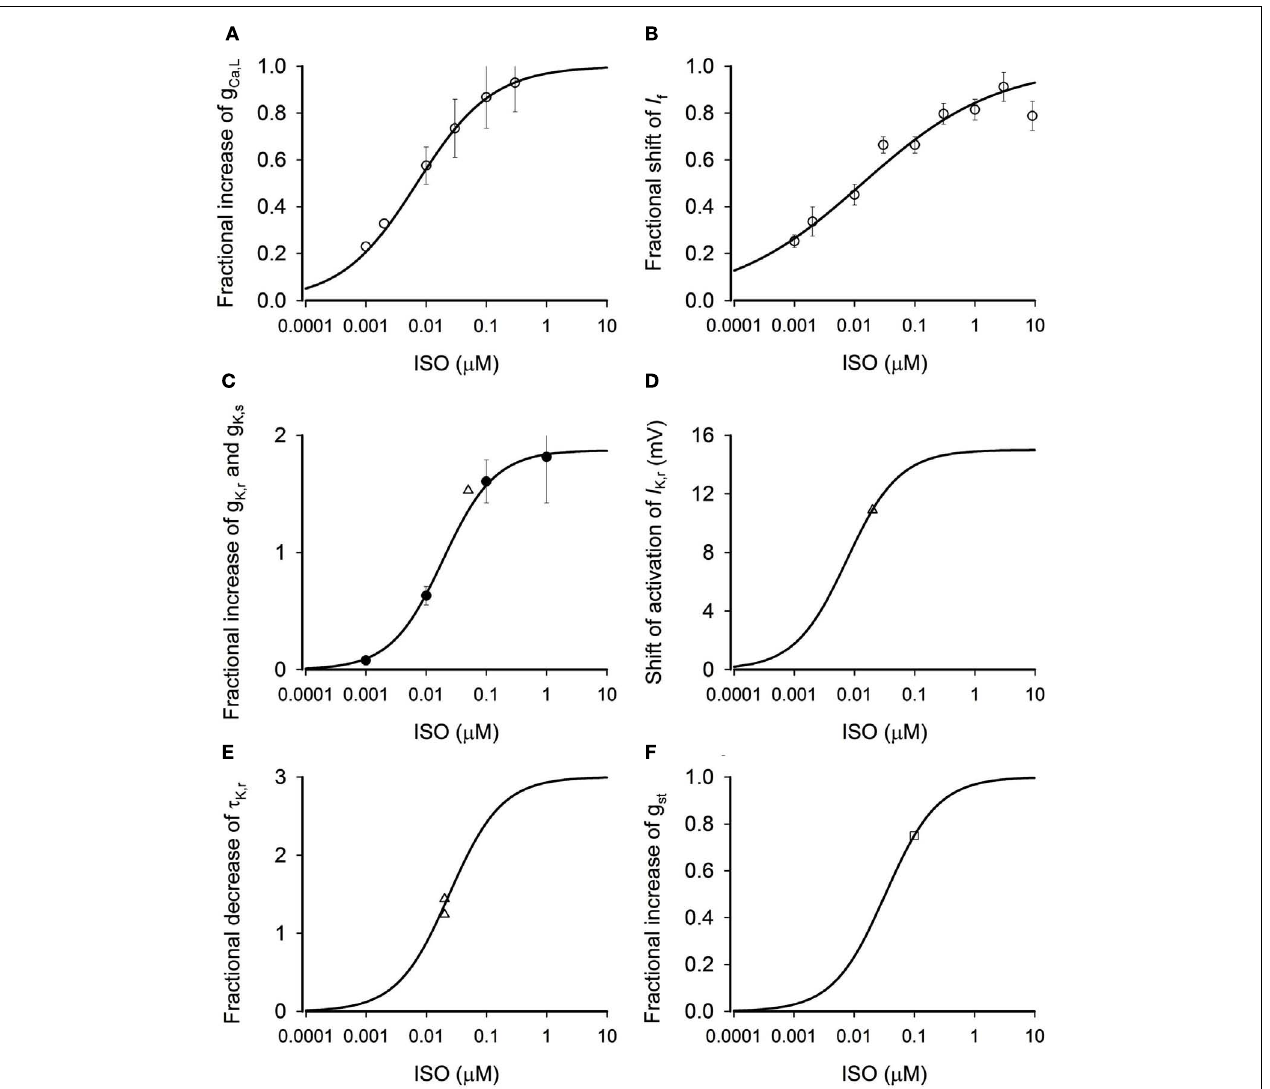
rabbit SAN cells. Solid line: computed from model. (D) Dose-dependent shift of I Kr activation curve. Open triangle: data from Lei et al. (2000) from rabbit SAN cells. Solid line: computed from model. (E) Dose-dependent fractional decrease of time constant of deactivation of I Kr . Open triangles: data from Lei et al. (2000) from rabbit SAN cells. Solid line: computed from model. (F) Dose-dependent fractional increase of g st . Open square: data from Guo et al. (1995) from rabbit SAN cells. Solid line: computed from